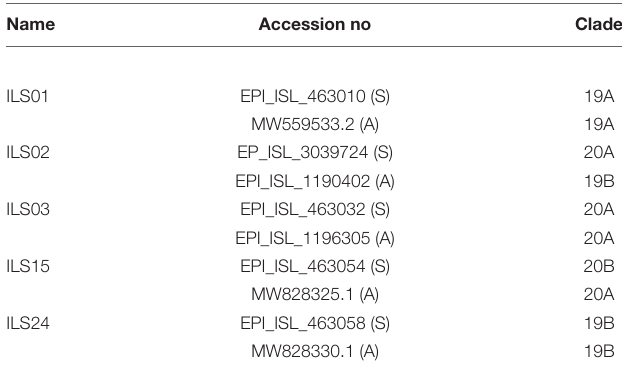
TABLE 2 | Accession numbers of the genome sequence and clade information of the viral RNA from source swab samples (S) and isolated and culture adapted viruses (A) used in this